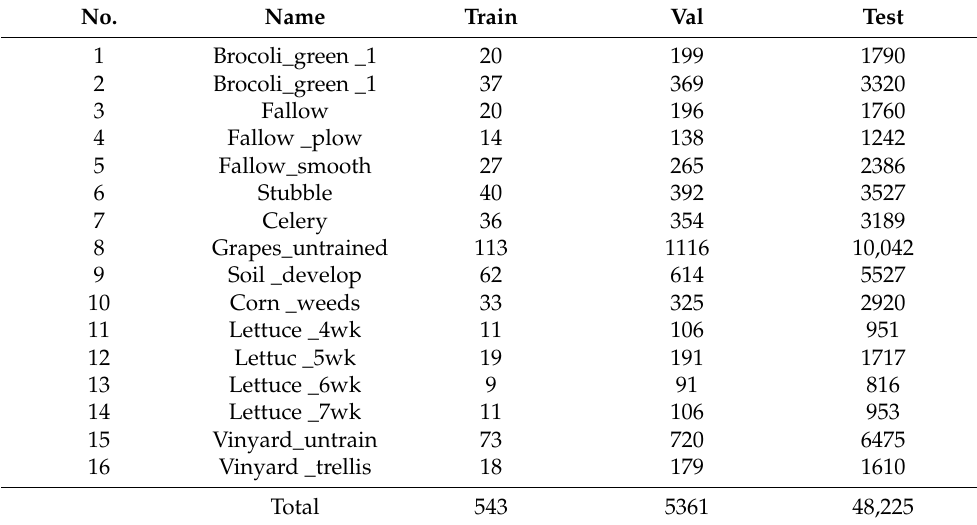
Table 3. The number of training, validation, and testing samples for Salinas Valley dataset.